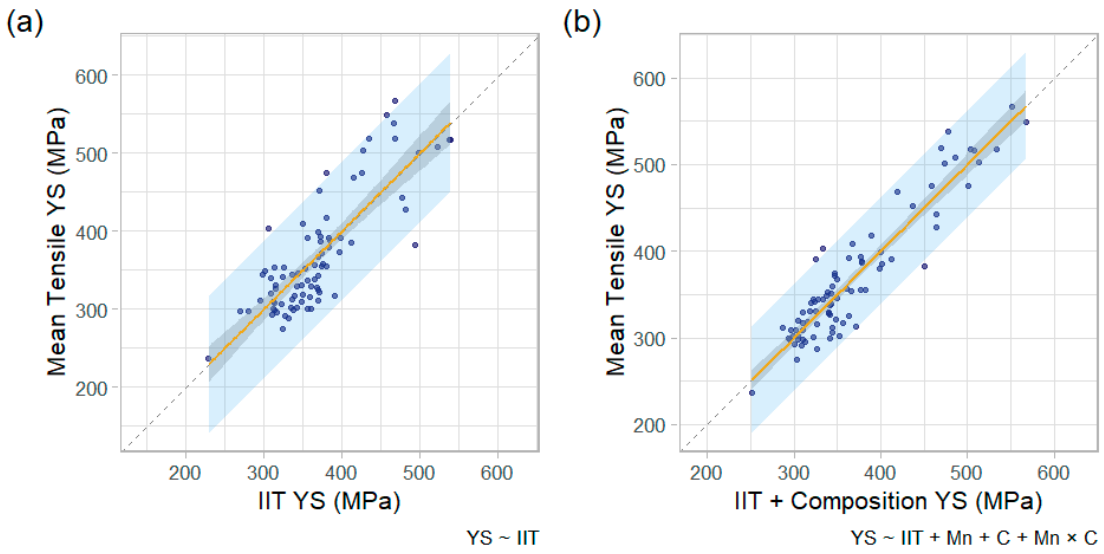
Figure 9. Error between mean IIT YS and mean tensile YS for each feature plotted against mass fraction manganese (wt.%) and mass fraction carbon (wt.%).